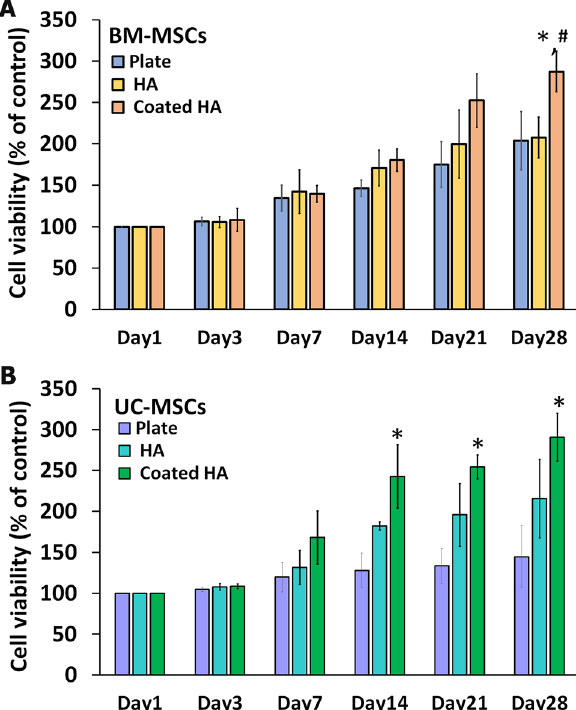
Figure 6. The viability of BM-MSCs ( A ) and UC MSCs ( B ) cultured with complete DMEM medium on the 3D-printed HA (HA), coated 3D-printed HA (coated HA), and plastic culture plate. The viabilities of MSCs in each type of scaffold are presented as % of control which is MSCs cultured on the same type of scaffold on culture day 1. N = 3, * P < 0.05 compared to MSCs cultured on a plastic culture plate. # P < 0.05 compared to MSCs cultured on 3D-printed